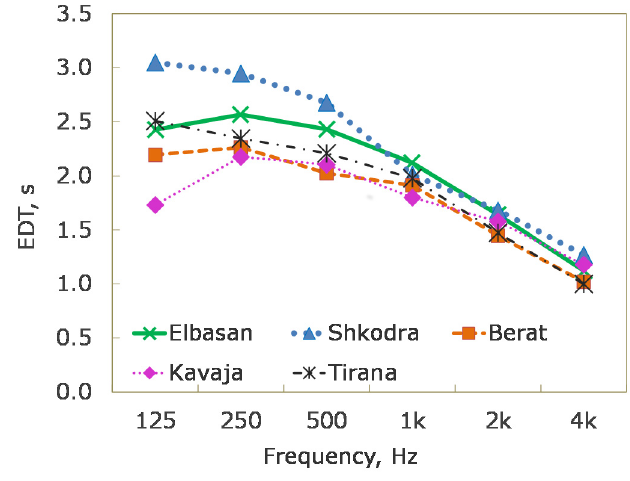
Figure 15. Measured results of early decay time (EDT).